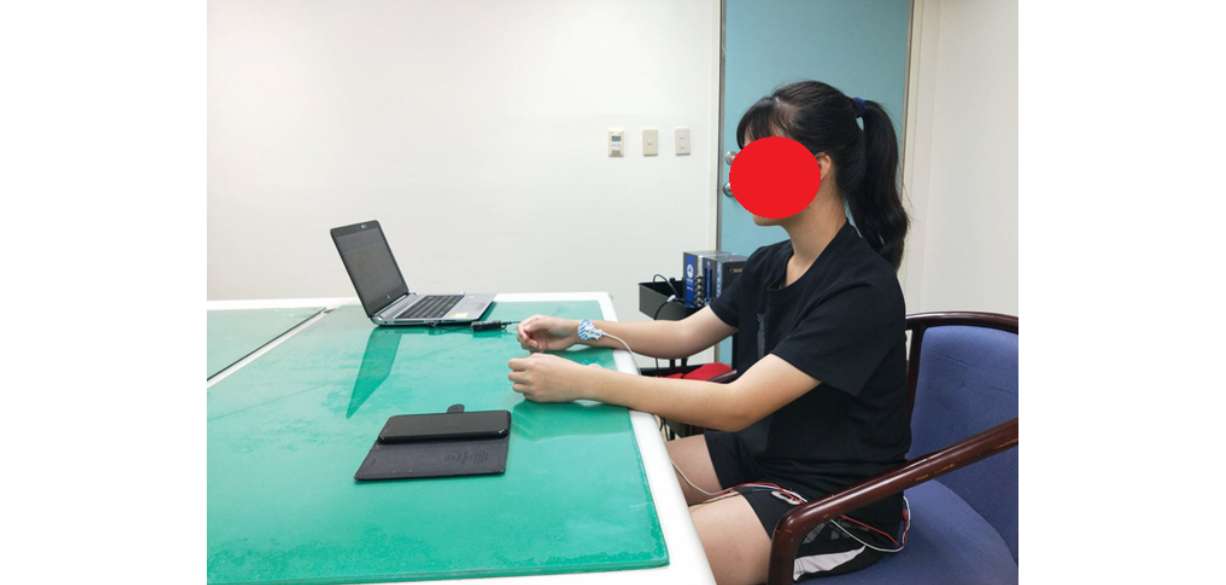
Figure 1. Illustration of the experimental setting and testing